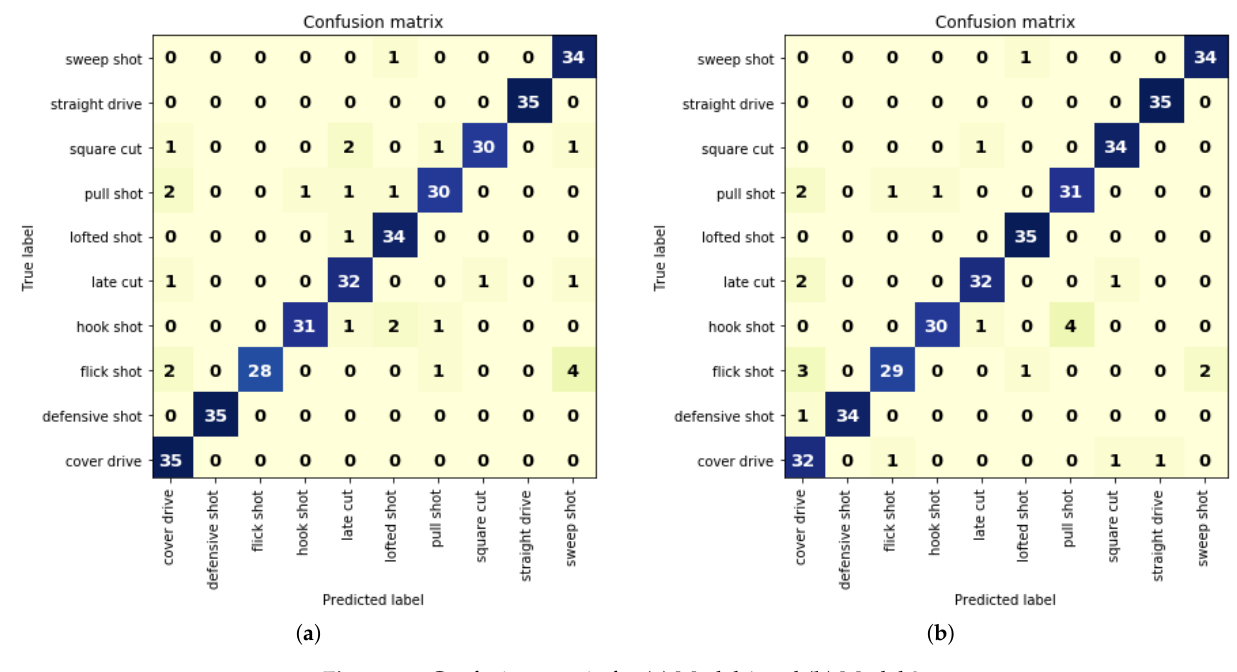
Figure 10. Confusion matrix for ( a ) Model 1 and ( b ) Model